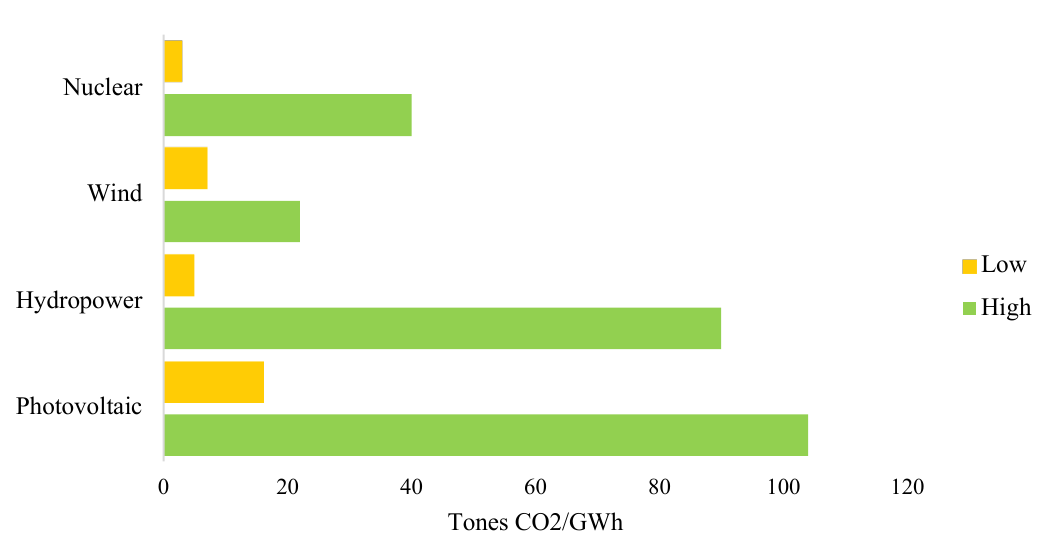
Figure 3. CO emissions from renewable and nuclear electricity production systems (Tones carbon 2 dioxide per GWh of electricity generated) ( WEC ,